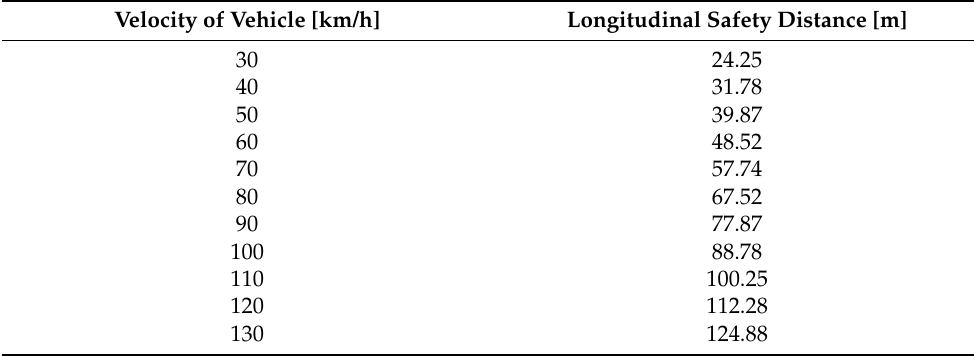
Table 4. Longitudinal safe distance between front and rear